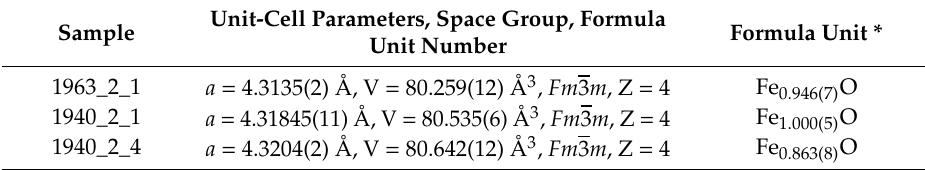
Table 4. Results of X-ray single-crystal analysis of wüstite